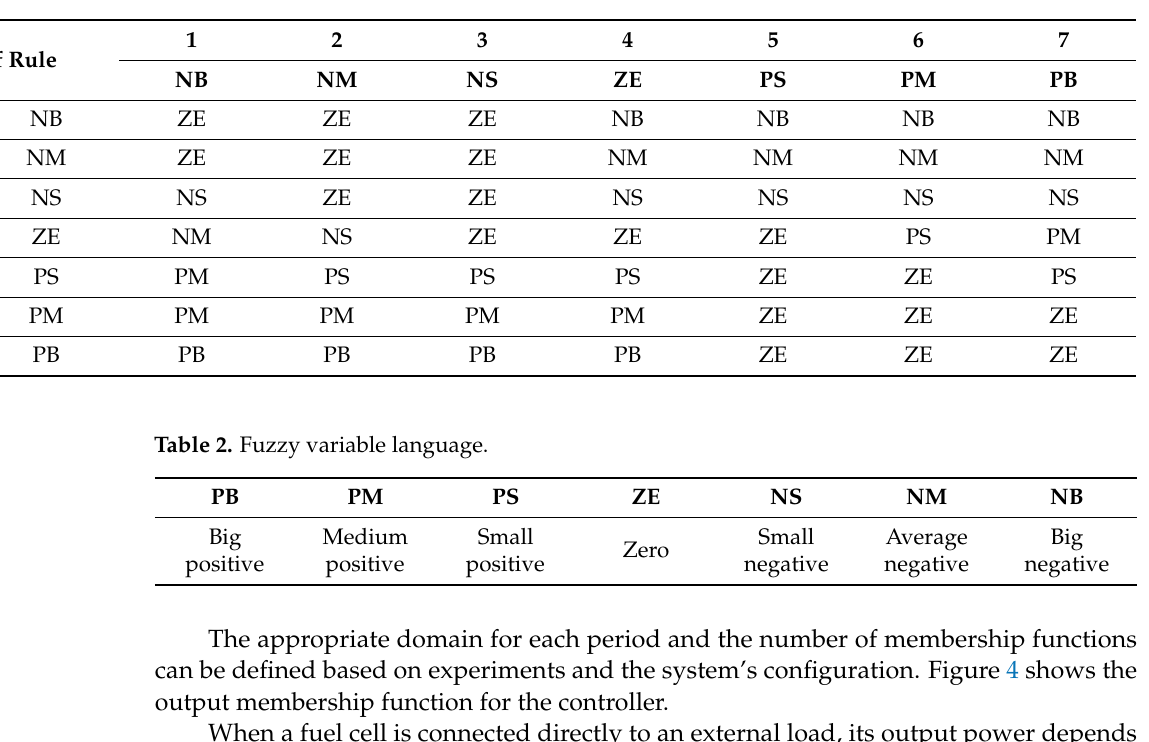
Figure 4. Output membership function. Table 1. Rule base for fuzzy controller [27,28].